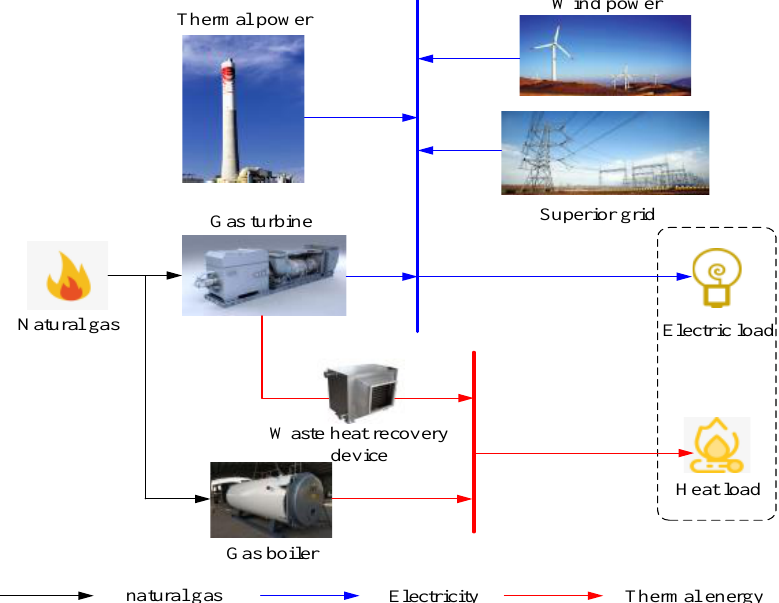
Figure 2. Operation framework for interdependent electric-heat network in the Integrated Energy System.